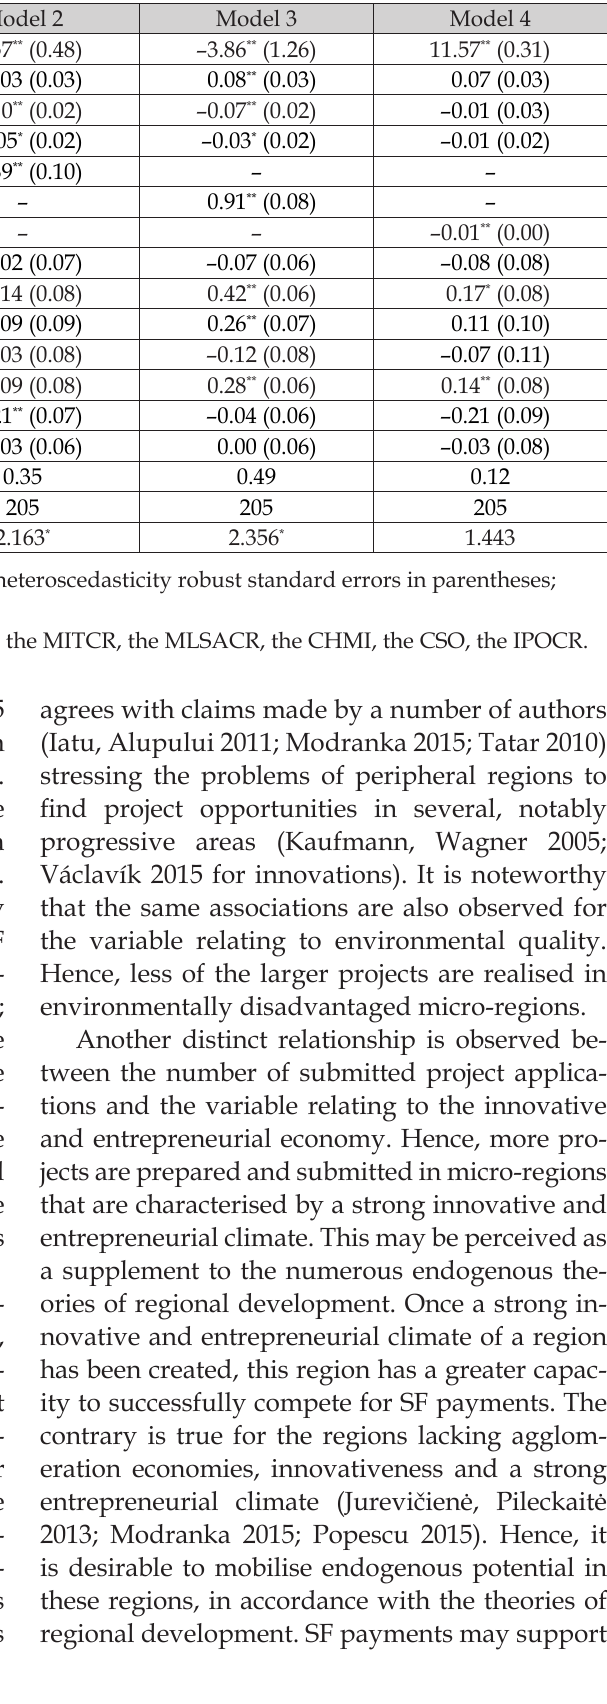
Table 7. Regression model